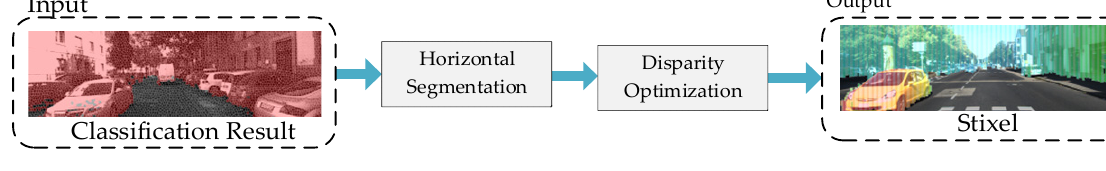
Figure 10. Flow chart of SGA-SO.